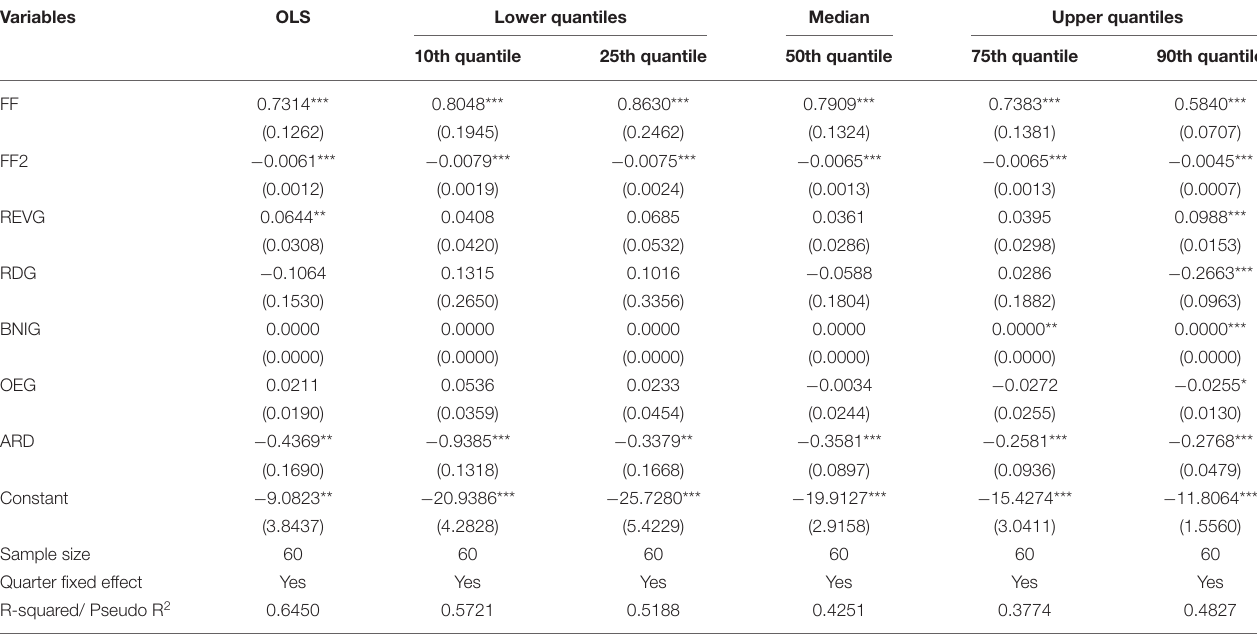
TABLE 8 | Robustness test results of SIZE: large firms.